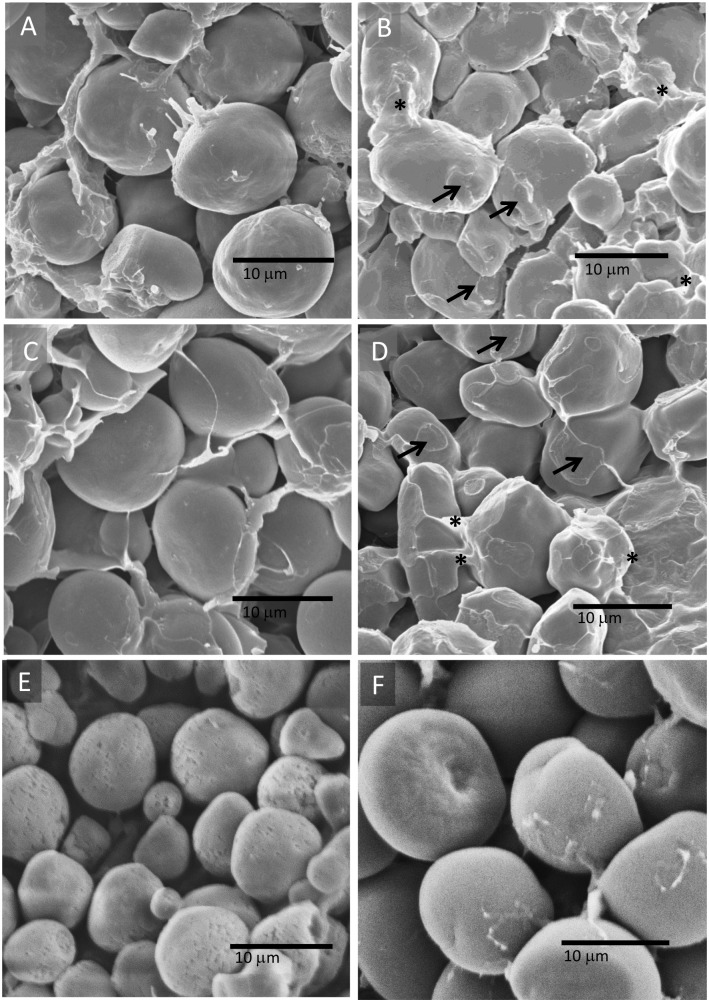
Scanning electron microscopy of starch granules from parental lines and RILs.(A) Smooth starch granules in W64Ao2 endosperm with a little matrix surrounding them. (B) Contacts (arrows) and interconnections (asterisks) formed between adjacent starch granules in K0326Y endosperm. (C) Starch granules in the endosperm of the opaque RIL 217 showed similar smooth surface as in W64Ao2. (D) Starch granules in the endosperm of RIL 27 showed similar contact and interconnection structure as in K0326Y. (E-F) Starch granules in the endosperm of RIL 209 (E) and RIL 112 (F) showed similar smooth surface as in W64Ao2.